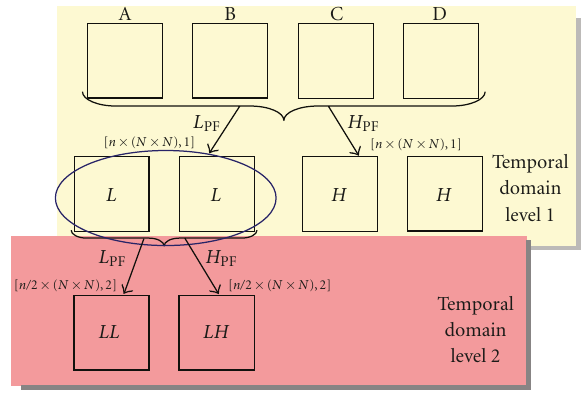
Figure 2: NoAl-classic algorithm: temporal decomposition. Figure 3: NoAl-classic algorithm: horizontal spatial decomposition (rows).